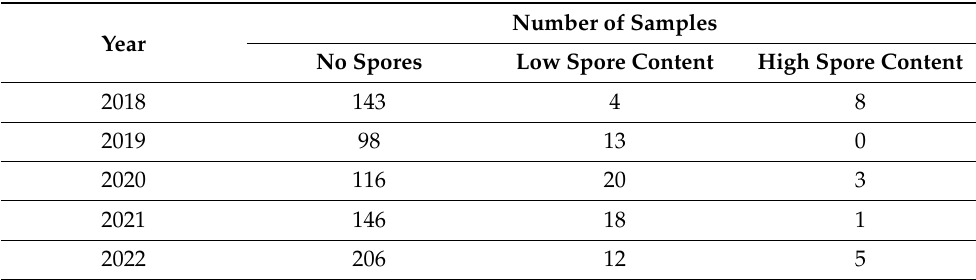
Table 3. Number of samples over the years.